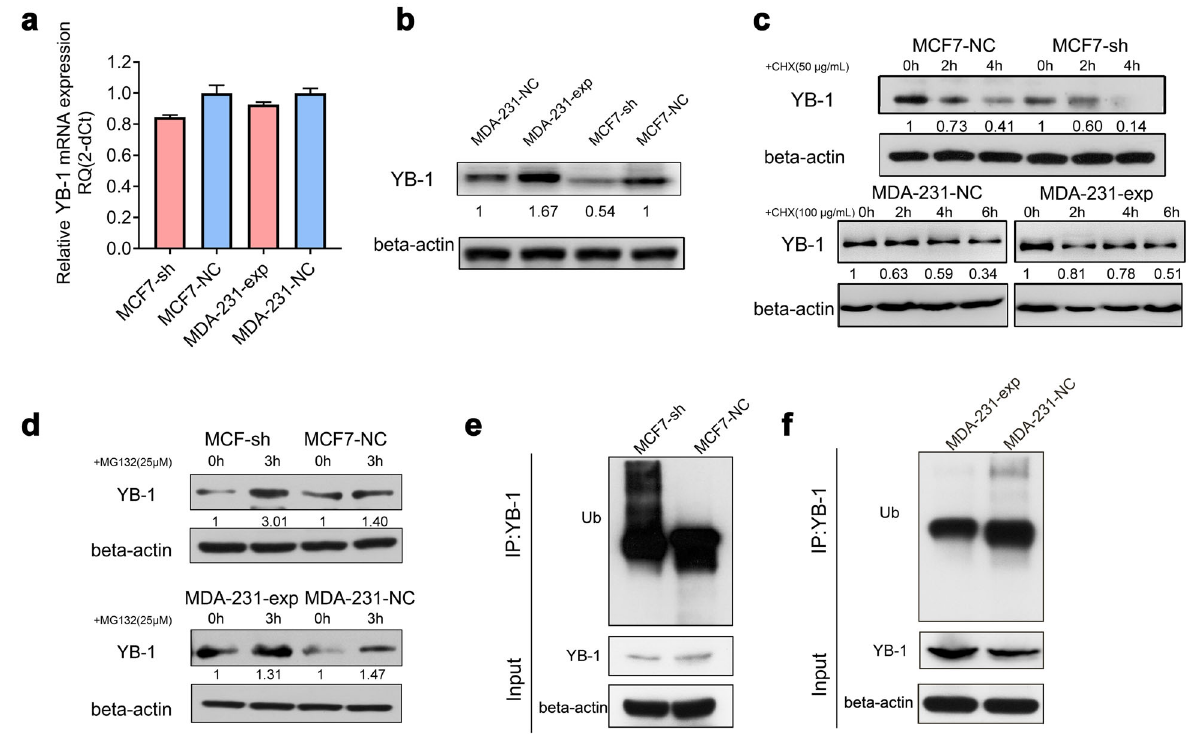
Fig. 5 MIR200CHG inhibits YB-1 ubiquitination and degradation. a qRT-PCR was used to detect the changes in the YB-1 mRNA when MIR200CHG was knocked down or overexpressed. b Western blotting was used to detect YB-1 expression when MIR200CHG was knocked down or overexpressed. c Western blotting was used to measure the expression of YB-1 in breast cancer cells following treatment with cycloheximide (CHX) after knockdown or overexpression of MIR200CHG. MCF7 cells were treated with 50 μ g/mL CHX for 2 or 4 h. MDA-MB-231 cells were treated with 100 μ g/mL CHX for 2, 4, or 6 h. d Western blotting was used to measure the expression of YB-1 in breast cancer cells that were treated with MG132 after knockdown or overexpression of MIR200CHG. Cells were treated with MG132 (25 μ M) for 3 h. e , f Cell lysates of MCF7-sh and its negative control, or MDA-231-exp and its negative control were subjected to YB-1 immunoprecipitation, and then anti-Ub antibody was used to detect the levels of ubiquitinated YB-1 by western blotting. The cells were treated with MG132 (10 μ M) for 24 h. Data in ( b – f ) are representative of at least two independent